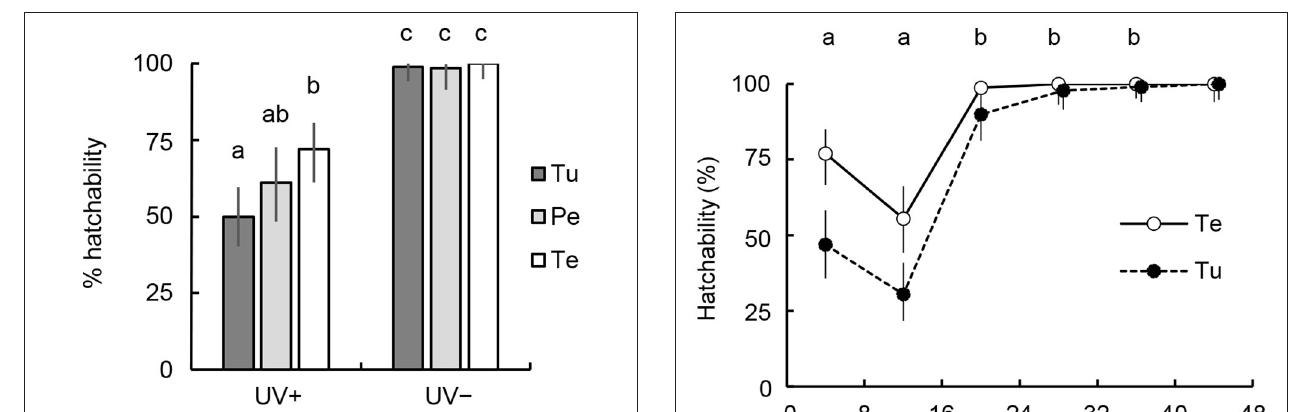
FIGURE 2 | Comparison of the hatchability of N. californicus eggs produced by females fed mites or pollen and irradiated with UVB at 0.192 kJ m − 2 . UV + , irradiated with UVB; UV–, untreated control. Prey and food sources of parental females were T. urticae (Tu), peach pollen (Pe), and tea pollen (Te). Vertical lines on bars show 95% CI. Different letters in each bar denote statistically significant differences (Fisher’s exact test, P < 0.05).